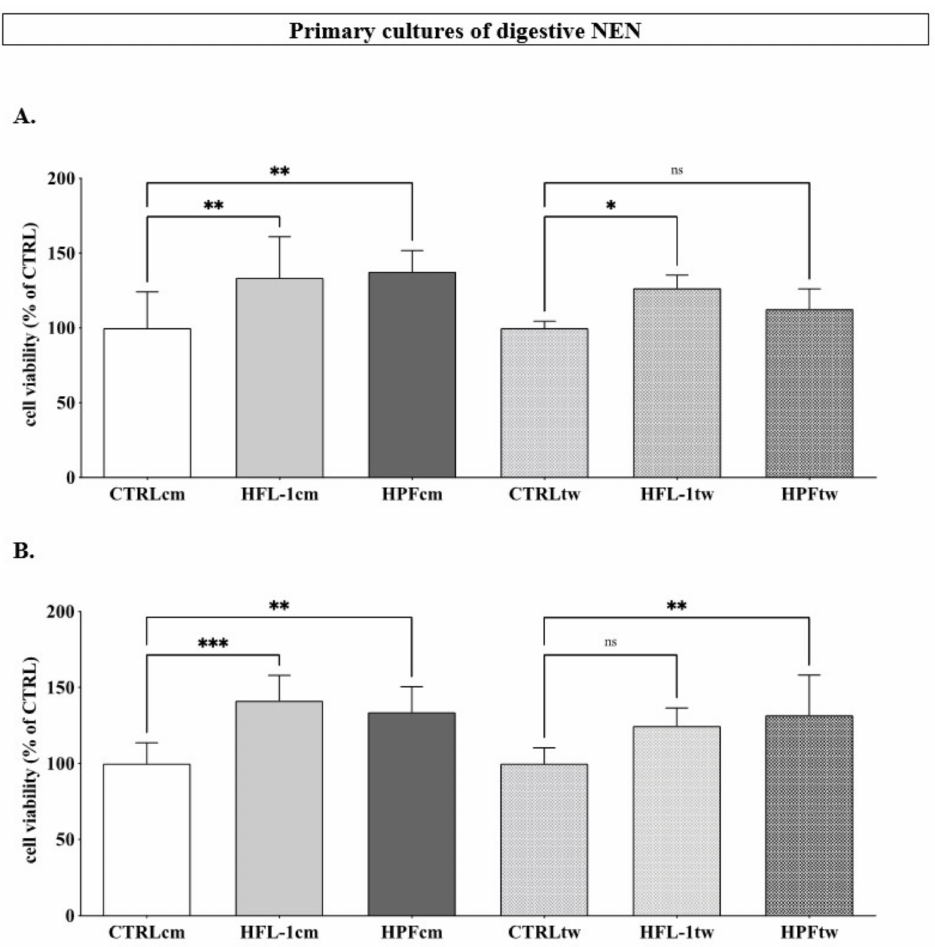
Figure 5. Impact of fibroblasts (conditioned medium (HFL-1cm/HPFcm) and transwell (HFL- 1tw/HPFtw)) on the cellular viability of primary culture of a human ileal ( A ) and pancreatic ( B ) neu- roendocrine neoplasms. *** p < 0.005; ** p < 0.01; * p < 0.05; ns: not